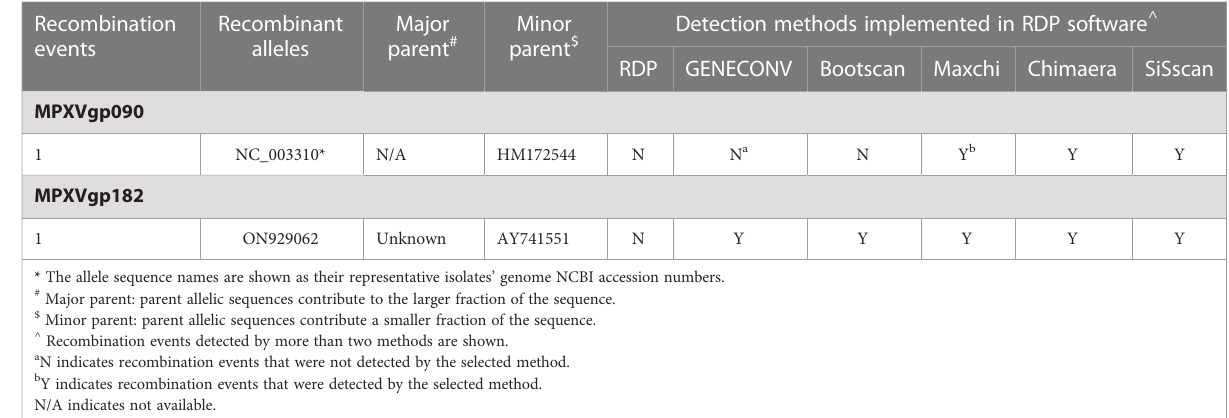
TABLE 1 Intragenic recombination among the gene sequences of monkeypox protein-coding genes by using six different methods implemented in the RDP software.